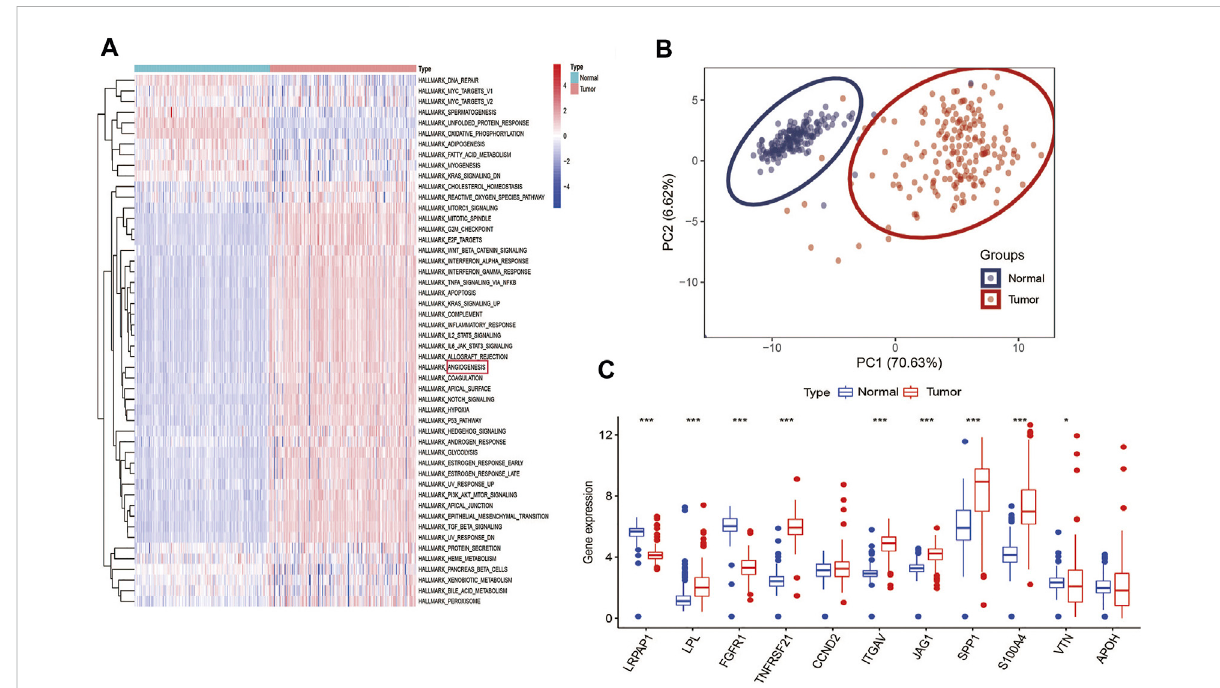
FIGURE 1 Angiogenesis as a cancer hallmark is hyperactivated in PC: (A) , GSVA analysis demonstrated that angiogenesis is hyperactivated in PC among various hallmarks of cancer; (B) PCA analysis demonstrated that PC and normal pancreas samples were evidently separated as two distinct groups with the11prognostic ARGs expression matrix; (C) Expression distributions of 11ARGs betweennormal and PC tissues. *** p < 0.001, ** p < 0.01,* p < 0.05 and not signi fi cant ( p > 0.05) by repeated measures with the Wilcoxon